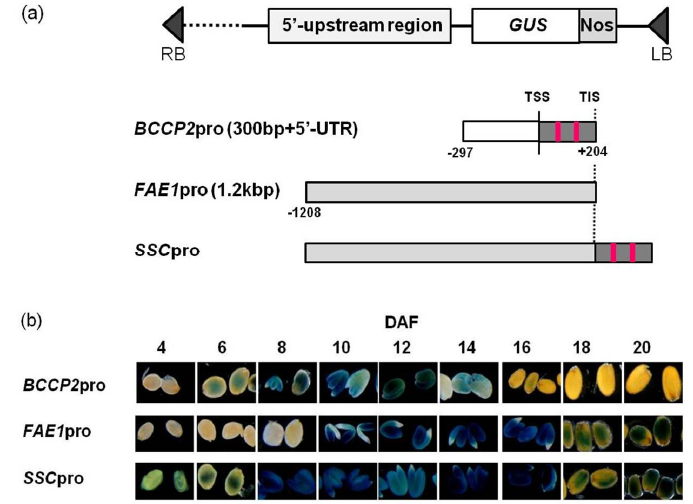
Figure 1. β-glucuronidase ( GUS ) expression analysis of transgenic plants containing the chimeric promoter. ( a ) Schematic diagram of the promoter: GUS constructs analyzed. The pink bars indicate the location of the AW box (WRI1 binding sequence). TIS: translational initiation sites. TSS: transcriptional start sites. LB: left border. RB: right border; ( b ) Histochemical staining of seeds at 4, 6, 8, 10, 12, 14, 16, 18 and 20 days after flowering (DAF) from plants carrying BCCP2pro:GUS , FAE1pro:GUS and SSCpro:GUS. For staining, seeds from #4 ( BCCP2pro:GUS ), #1 ( FAE1pro:GUS ) and #7 ( SSCpro:GUS) in Figure 2 were used.